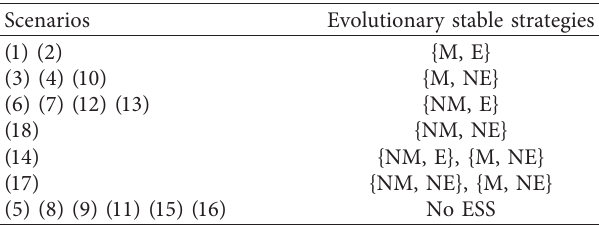
Figure 10: The replication dynamic phase map for scenarios (5), (8), (9), (11), (15), and (16). Table 6: Summary of the evolutionary stable strategies of 18